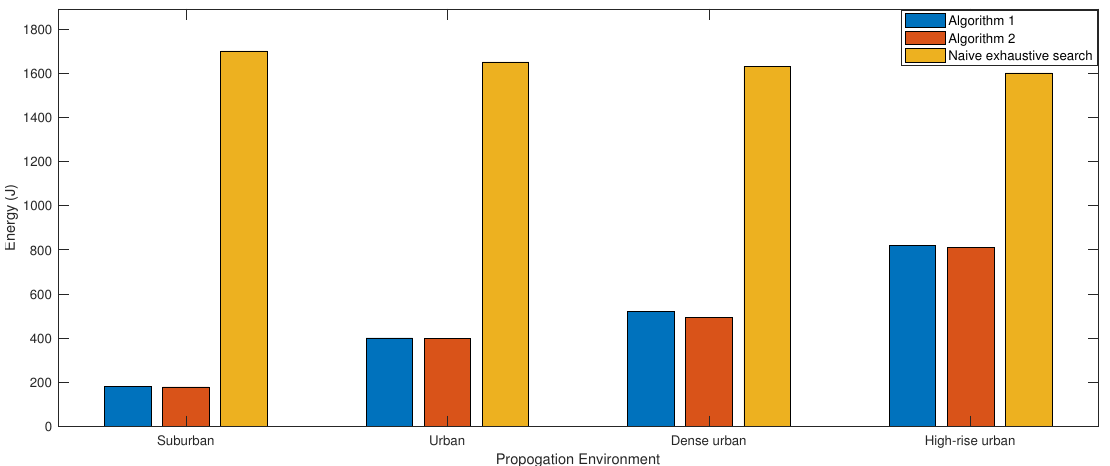
Figure 9. Energy consumption of Algorithms 1 and 2 compared to naive exhaustive search.